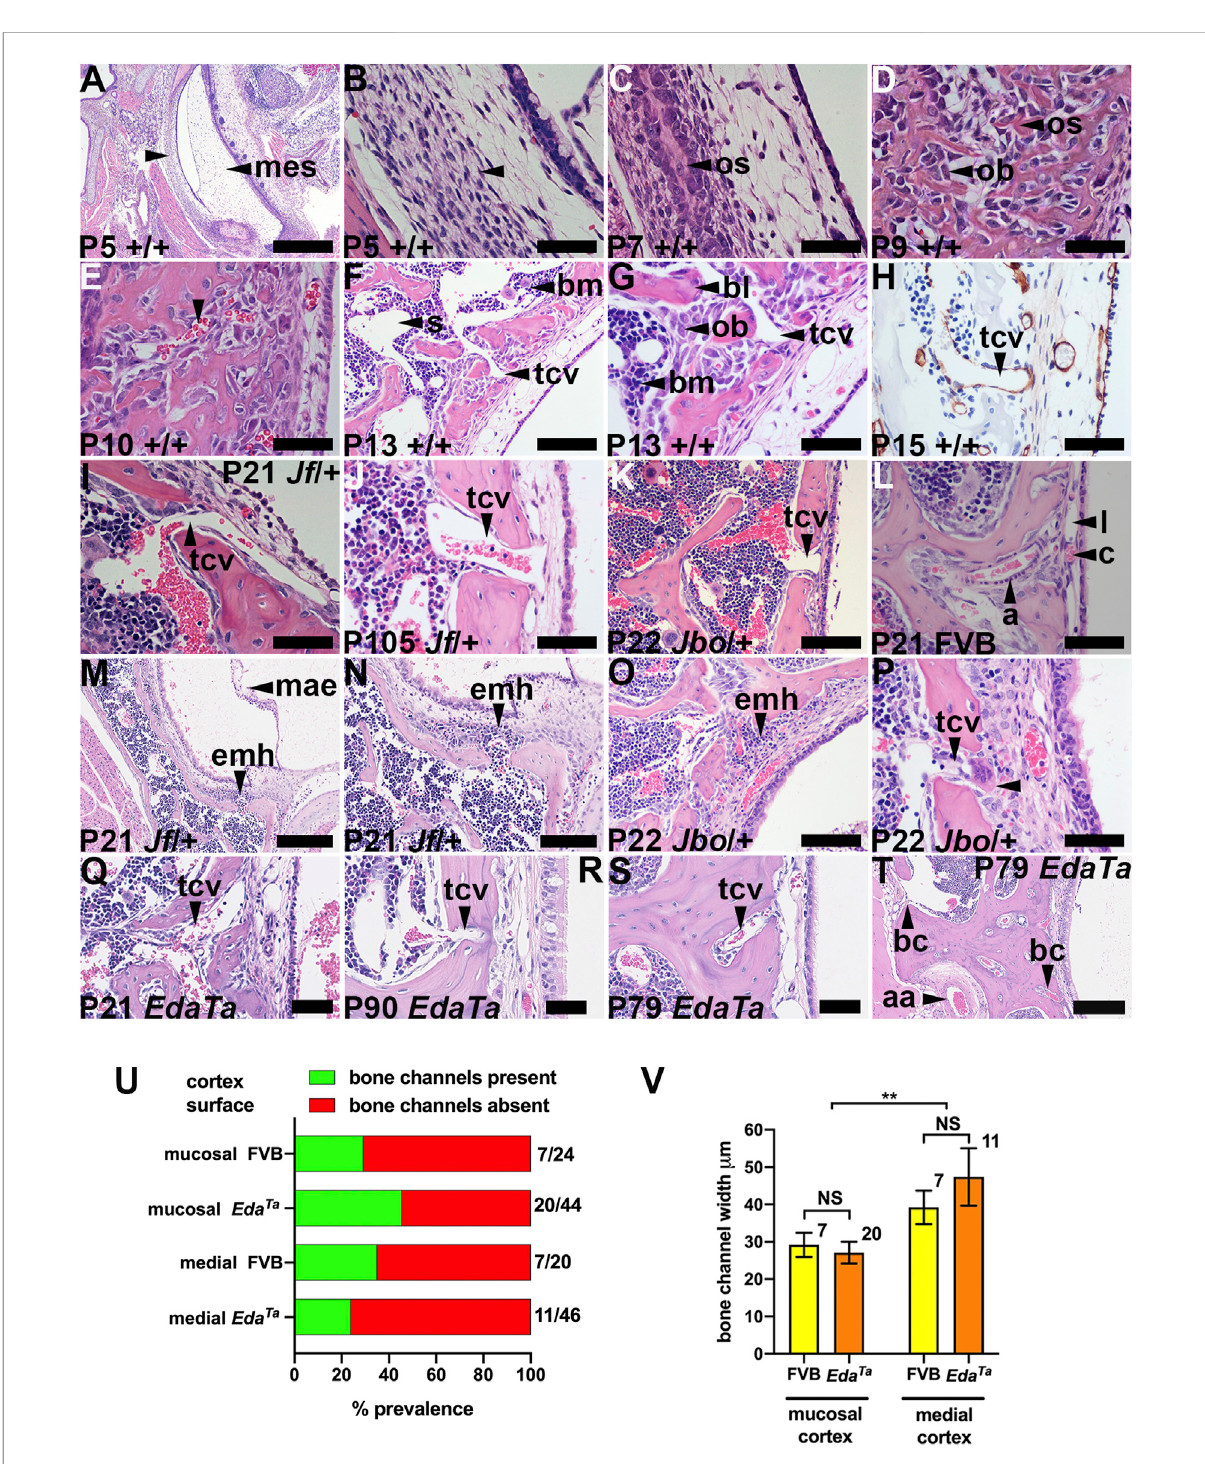
FIGURE 1 Temporal bone trans-cortical vessels connect bone marrow to bulla mucosa. Dorsal plane sections rostral uppermost. (A,B) (F,G) , and (M,N) are low and high magni fi cation images of the same section. (A – H) Intramembranous ossi fi cation of tympanic temporal bone in wild- type mice (mixed C57BL/6J and C3H/HeH genetic background). (A,B) P5 bone primordium consists of mesenchymal osteoprogenitor cells. Osteoblast and osteoid at (C) P7 and (D) P9, (E) P10 bone marrow vascular channels (arrowhead), (F,G) P13 lamellar bone formation by osteoblasts, bone marrow and sinuses, and TCV extending through a bone channel. (H) TCV basal lamina stains for laminin. (I – L) TCVs connecting marrow with mucosa. (L) P21 FVB mucosa has capillary and lymphatic vessels and an arteriole bordered by pericytes. (M-P) Extra medullary haematopoiesis in mucosa. (P) A megakaryocyte (arrowhead) in a periosteal location. TCV in (Q) P21 Eda Ta mice extends through